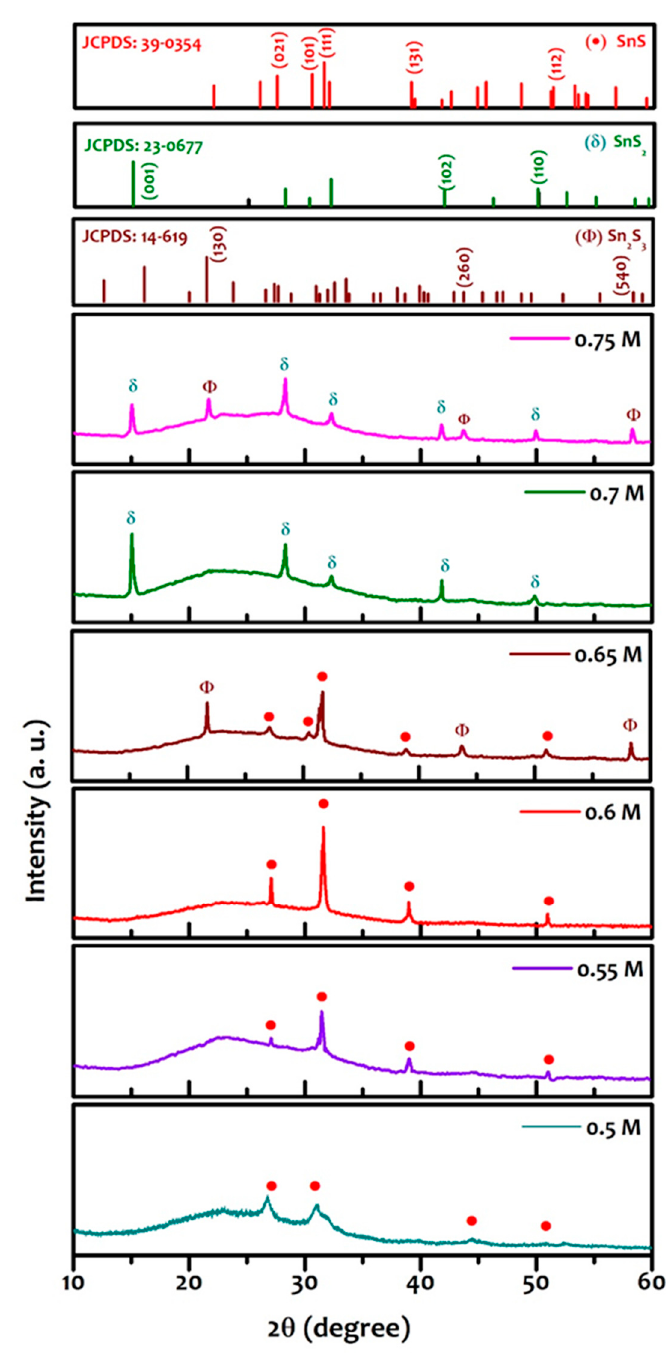
Figure 4. XRD patterns of the films deposited at di ff erent TA Figure 4 . XRD patterns of the films deposited at different TA concentrations. 153